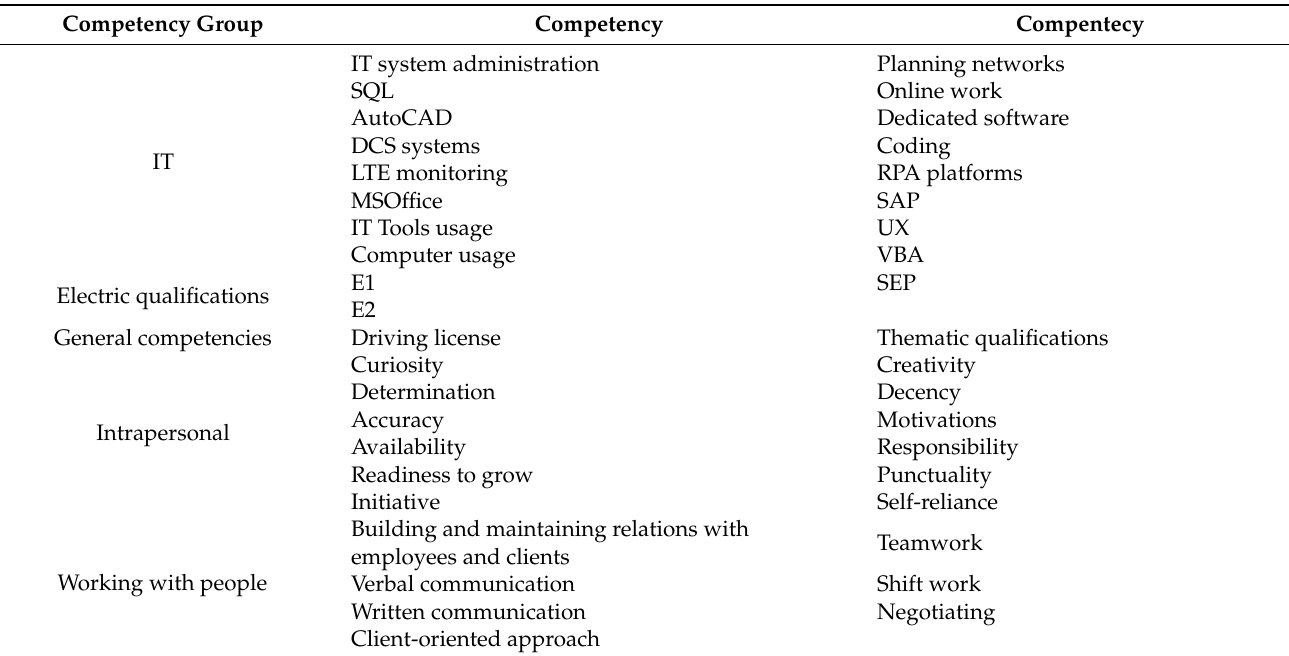
Table 10. Competency groups and what is